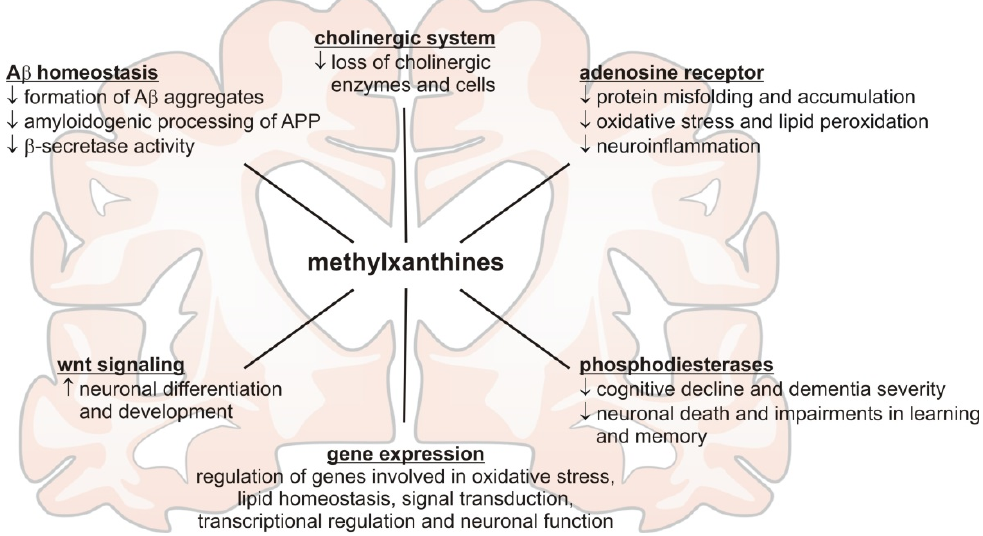
Figure 1. Summary of the molecular mechanisms reported in recent literature potentially mediating the beneficial effects of methylxanthines in respect to Alzheimer´s disease.